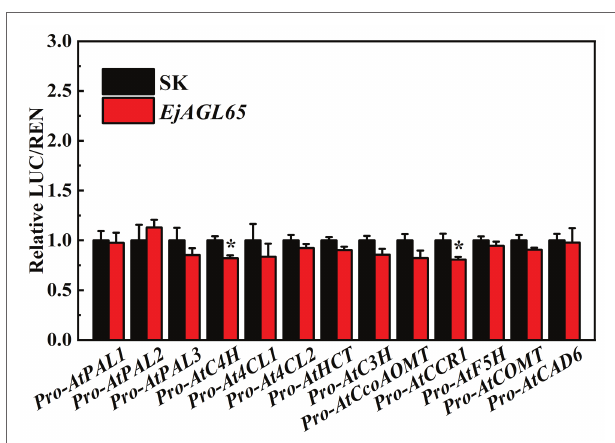
FIGURE 5 | Interactions between EjAGL65 and Arabidopsis genes involved in lignin biosynthesis. A combination of the empty SK vector and LUC vectors with different promoters was used as a calibration (set as 1). Error bars resulted from five replicates. The asterisk indicates that the relative LUC/REN value was significantly different between SK and EjAGL65 based on the Student’s t -test at a significance level of 0.05.